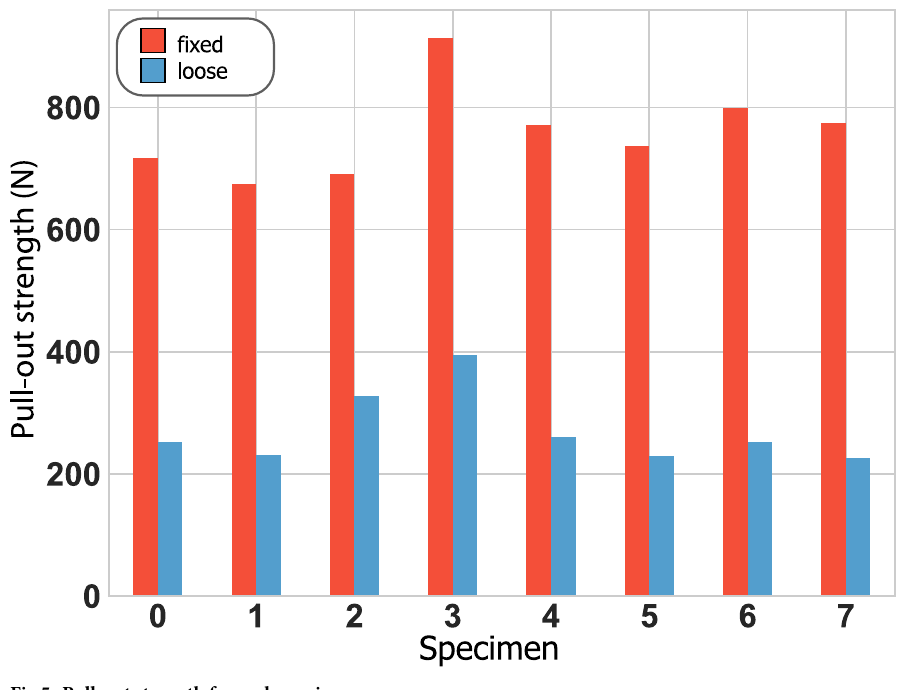
Fig 5. Pull-out strength for each specimen.